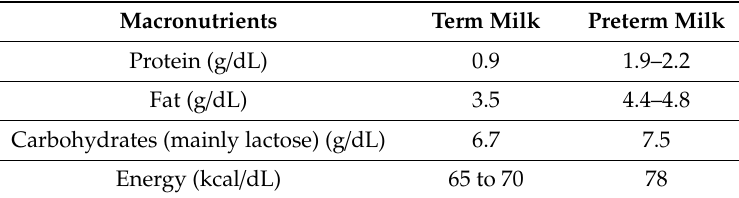
Table 1. Composition of term and preterm human milk.